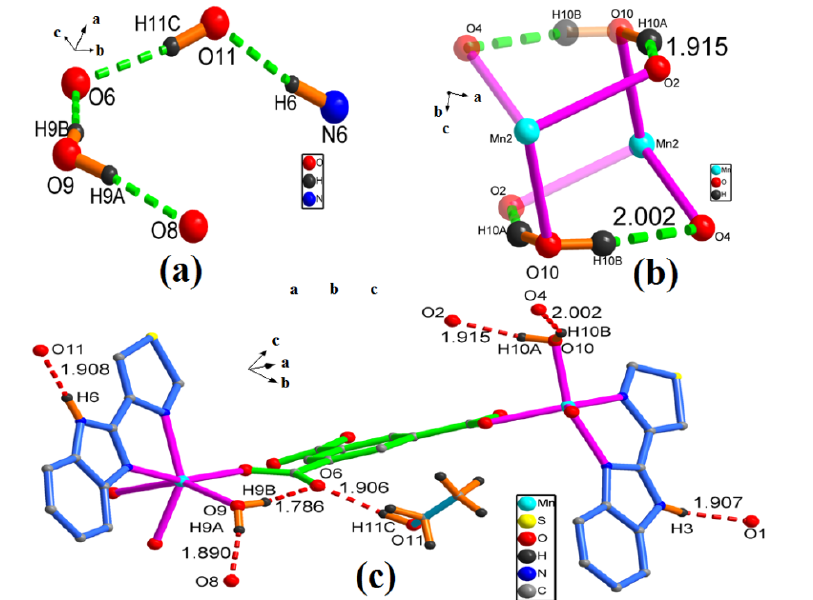
Figure 6. ( a ) The H-bonding chain in complex 2 , Unnecessary atoms are omitted for clarity. ( b ) View of the irregular polyhedron created by the H-bonding and the two coordinated water (O10). ( c ) A perspective view of H-bonding for complex 2 , Unnecessary atoms are omitted for